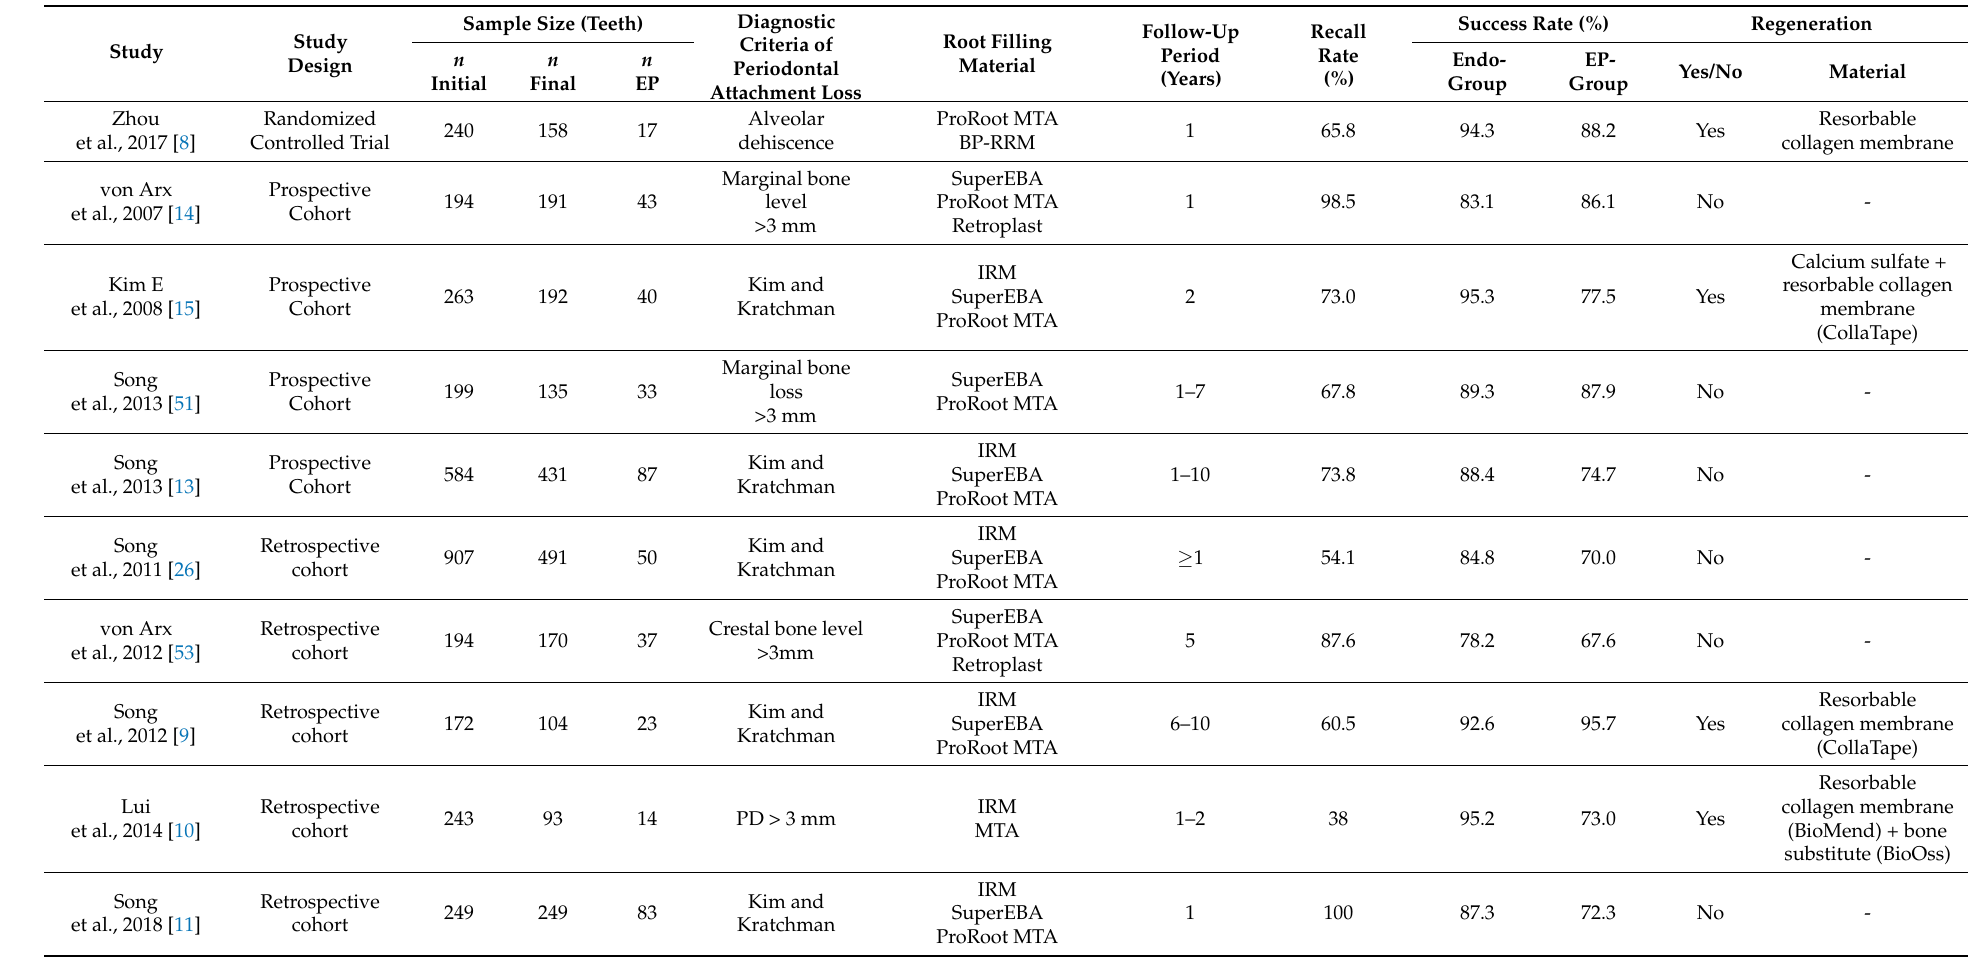
Table 2. Summary of the studies included in the systematic